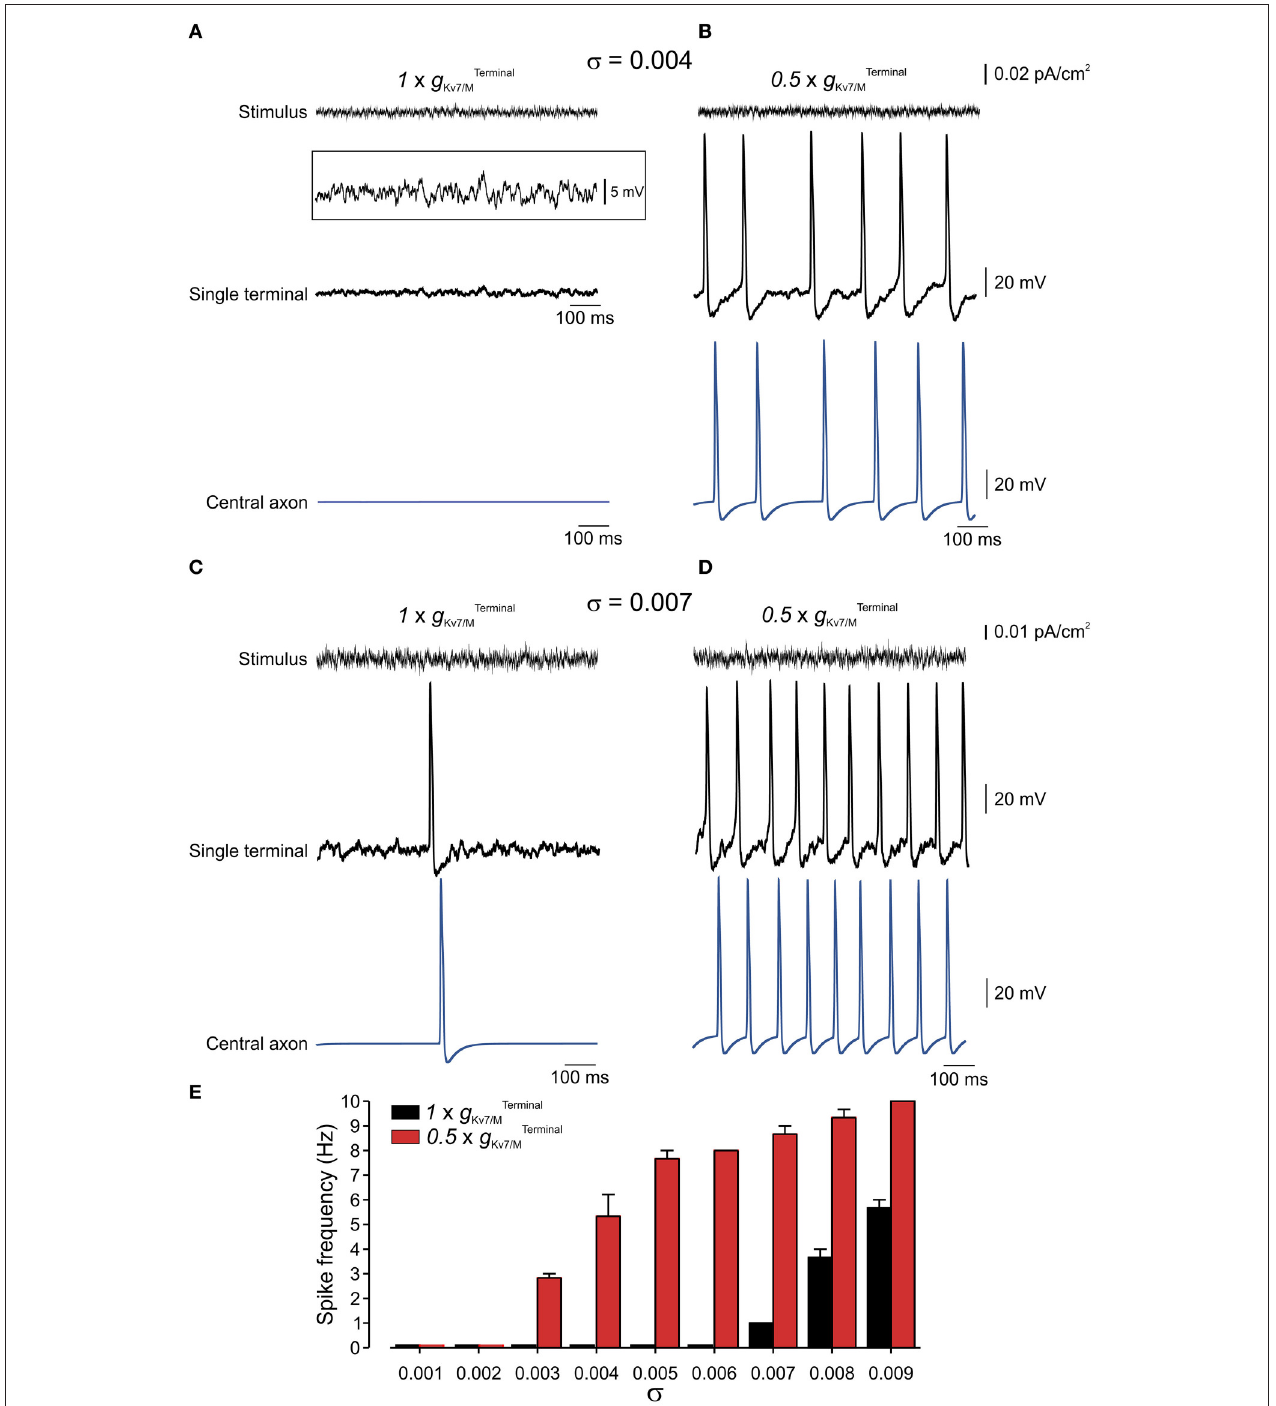
FIGURE 7 | Terminal g Kv7 / M opposes membrane potential fluctuations. (A) Upper, Example of current noise trace ( σ = 0.004) injected into the whole terminal tree of the multi-compartment model of the nociceptive neuron with intact g Terminal Kv7 / M . Middle, simulated recordings of changes in membrane voltage in single terminal following injection of the current noise (shown above), expanded in y-axis in inset . Lower , simulated recordings of changes in membrane voltage in central axon ( blue electrode in Figure 4 ) following injection of the current noise (shown above) to the terminal tree. Note that at this noise level no activity is elicited at either terminal or soma. (B) Same as (A) but g Terminal Kv7 / M is reduced by half (0.5 x g Terminal Kv7 / M ). (C,D) Same as (A,B) but with σ = 0.007. (E) Graph plotting changes in spike frequency with σ of current noise when g Terminal Kv7 / M intact ( black ) and reduced by half ( red ). Each bar represents 3 trials with a random noise input (see Methods). Note, increase in spike frequency as g Terminal Kv7 / M